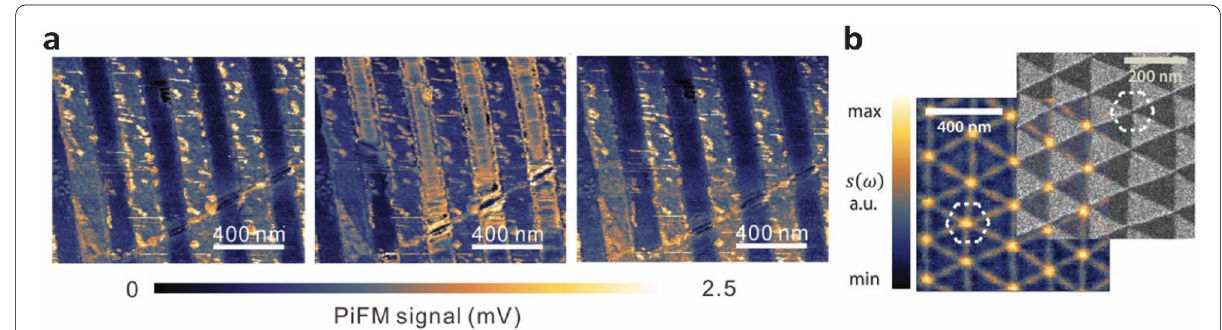
Fig. 2 Interaction of graphene plasmons with carrier concentrations and Moiré superlattice. a Near-field images of graphene under selective doping by a patterned substrate at 1380 cm − 1 (left), 1496 cm − 1 (middle), and 1591 cm − 1 (right) excitation conditions. Reprinted with permission from [39]. Copyright 2018 WILEY-VCH Verlag GmbH & Co. KGaA, Weinheim. b Near-field image (left) of a twisted bilayer graphene overlapped with dark field TEM image (right). The dashed hexagon denotes unit cell of the light-matter interaction pattern. From [40], Reprinted with permission from